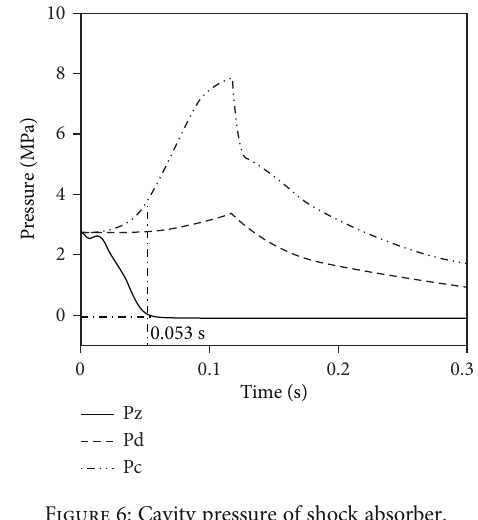
Figure 6: Cavity pressure of shock absorber.